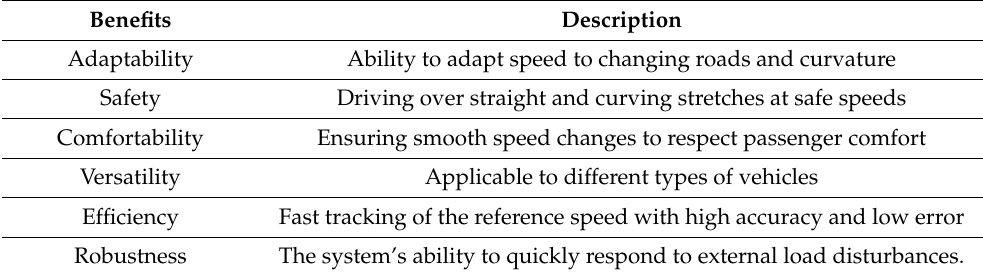
Table 3. Benefits of speed planning algorithm and back ‐ stepping approach.